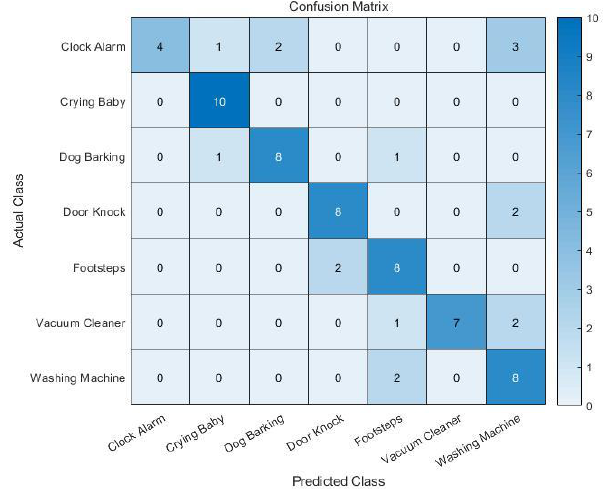
Figure 20. Test results of the trained system.